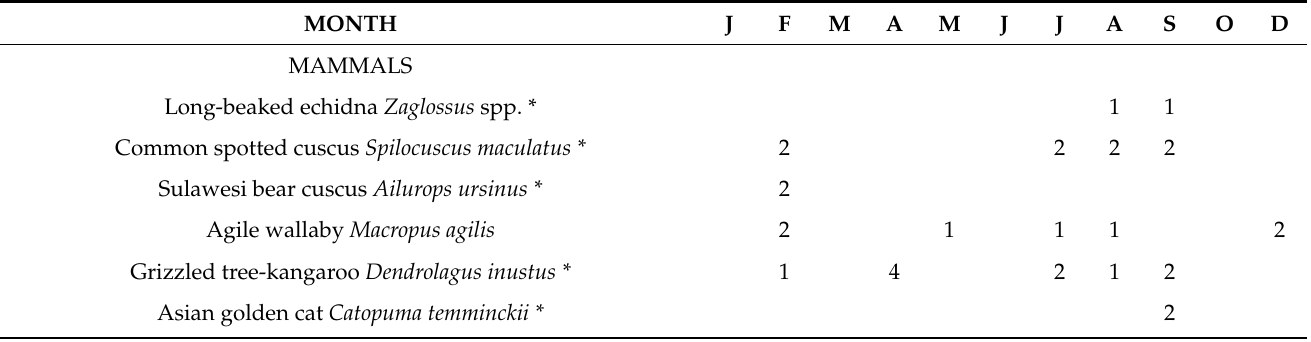
Table 2. One year (2020) of advertisements on Instagram from one pet shop based in Java (type B in Figure 1), Indonesia, that, besides apes (highlighted in the gray bars), specializes in the sale of other mammals and non-passerine birds. No adverts were posted between 24 October and 16 December 2020. All species occur in Indonesia, apart from the four indicated in bold. * Protected